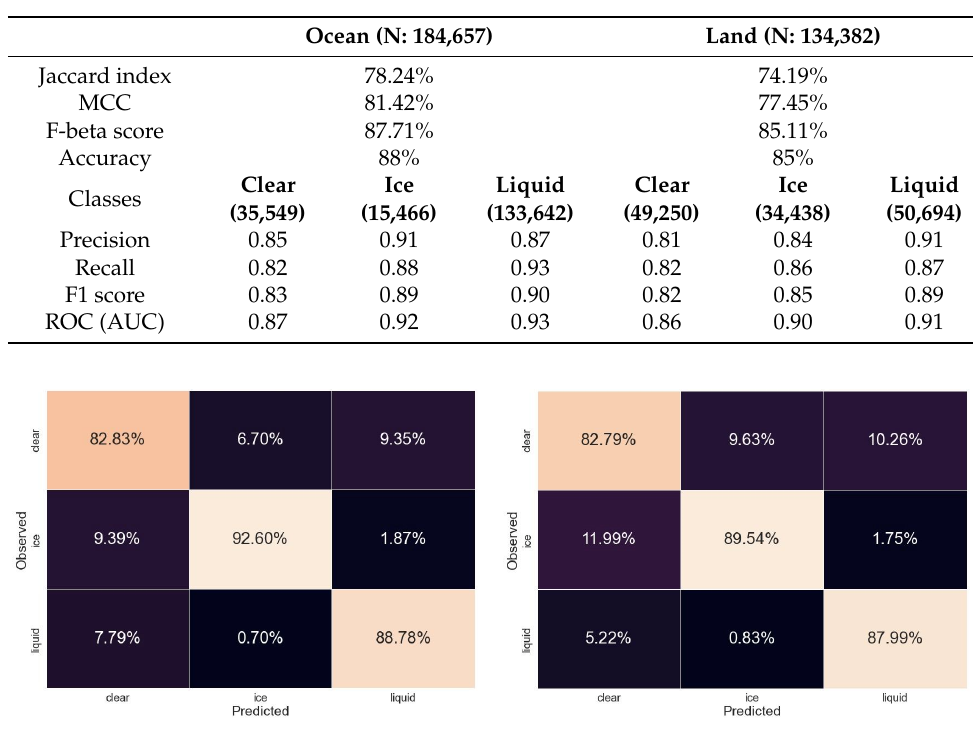
Figure 6. Confusion matrices for clear, ice and liquid predictions by NN models over the ocean ( left panel ) and over land ( right panel ) using the synthetic MWS dataset. The lighter boxes represent the number of pixels correctly classified for each of the classes, while the darker boxes represent misclassifications.